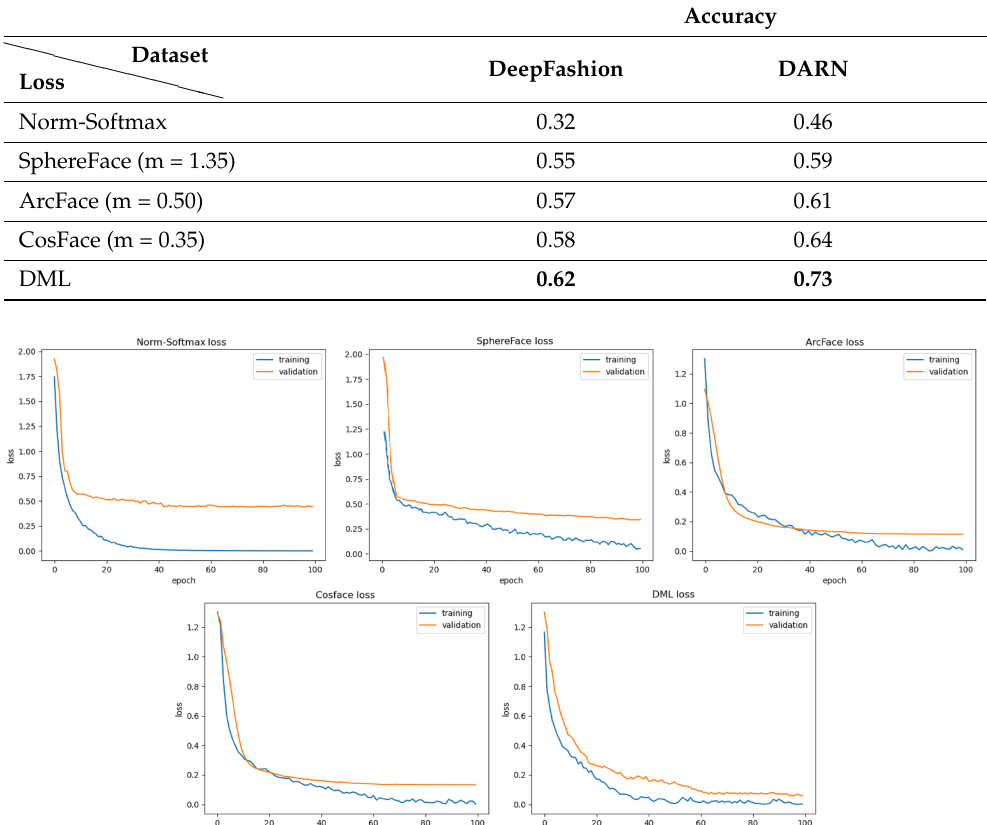
Table 4. Comparison of the proposed DML with state-of-the-art margin-based loss functions in Consumer-to-Shop Clothes Retrieval (top-20). All methods in this table used the same training data and the same Siamese network architecture. Bold shows the the best rate.